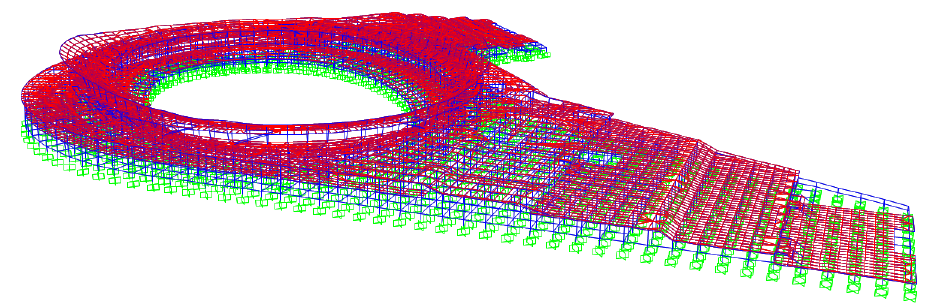
Figure 6. Structure model